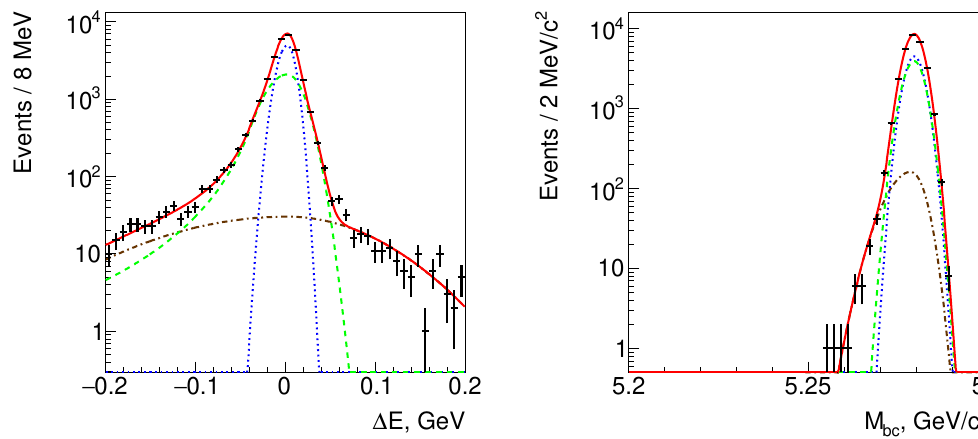
Figure 1 . Projections of the resolution (cid:12)t results onto (cid:1) E and M bc for the channel B + (cid:17) c 2 (1 D ) K + with (cid:17) c K + K 0 (cid:25) (cid:0) . The points with error bars are truth-matched signal MC, the red S ! solid curve is the (cid:12)t result, the green dashed curve is the Crystal Ball component, the blue dotted curve is the (cid:12)rst Gaussian component, and the brown dash-dotted curve is the second Gaussian component.